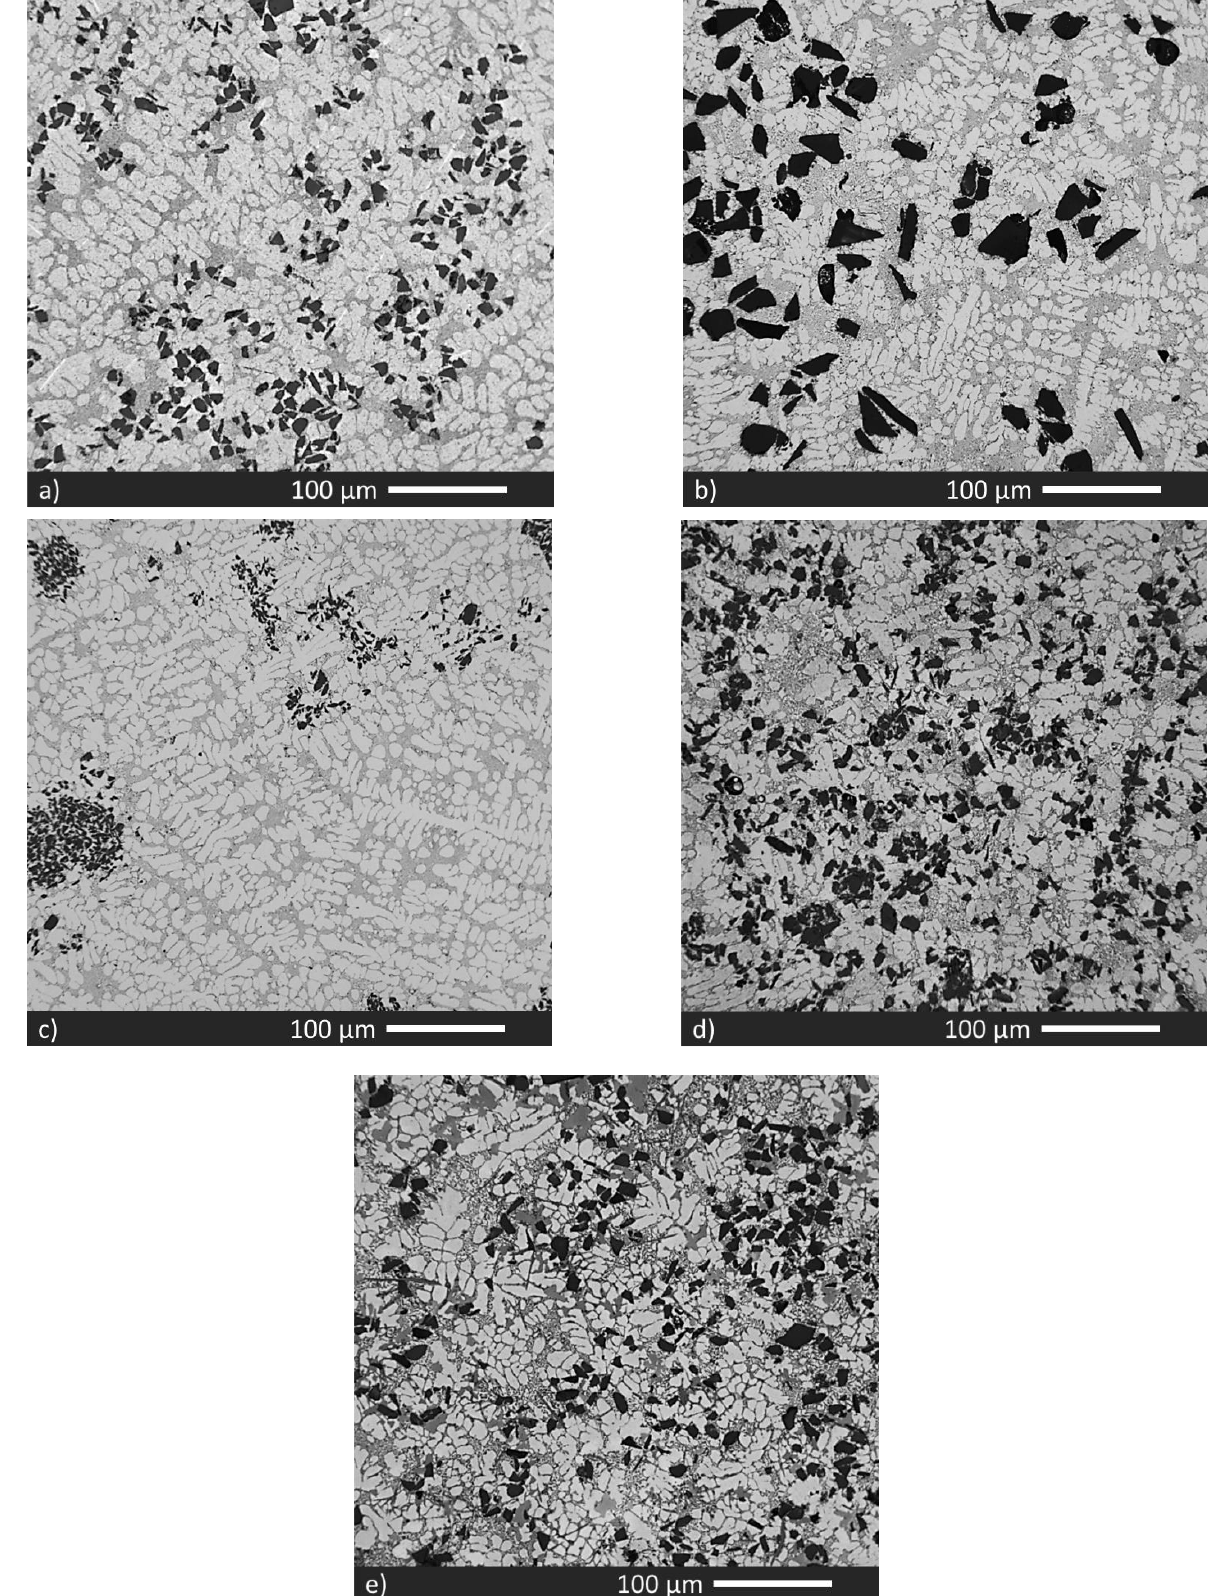
Figure 1. Micrographs: ( a ) material C0_23; ( b ) material C0_50; ( c ) material C0_10; ( d ) material C0_mix; ( e ) material C1_23.